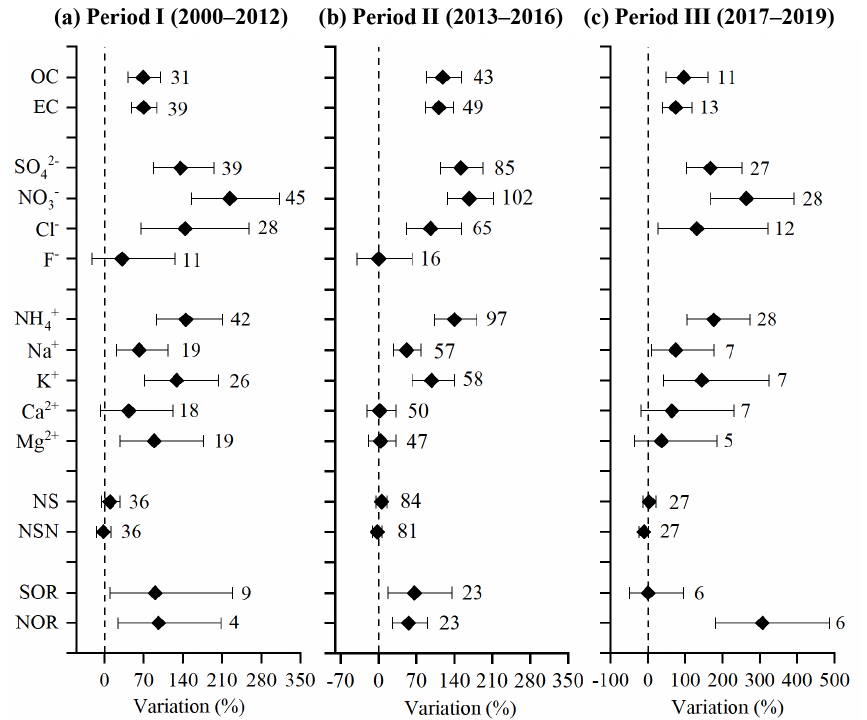
Figure 5. Variations in PM 2 . 5 composition, NS, NSN, SOR, and NOR from non-hazy to hazy days in (a) period I (2000–2012), (b) period II (2013–2016), (c) period III (2017–2019). NS is the slope of the regression equation between [NH + ] and [SO 2 − ], NSN is the slope of the 4 4 + NO − regression equation between [NH + ] and [SO 2 − ], SOR is sulfur oxidation ratio, and NOR is nitrogen oxidation ratio. The variations 4 4 3 are statistically significant if the confidence intervals of the effect size do not overlap with zero. Values adjacent to each confidence interval indicate number of measurement sites. The n represents independent sites; more details on this are presented in Sect.